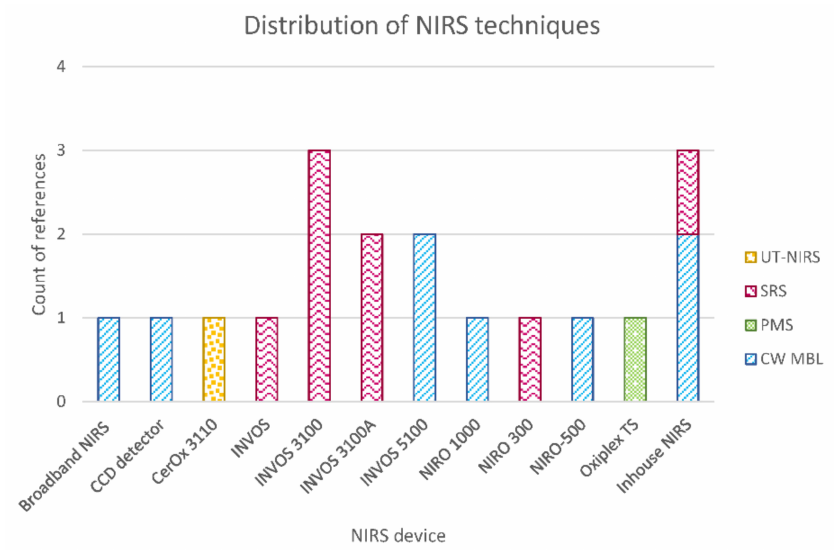
Figure 9. Distribution of NIRS techniques used for oxygenation monitoring in TBI patients. Where continuous wave modified Beer–Lamber law (CW MBL), spatially resolved spectroscopy (SRS),